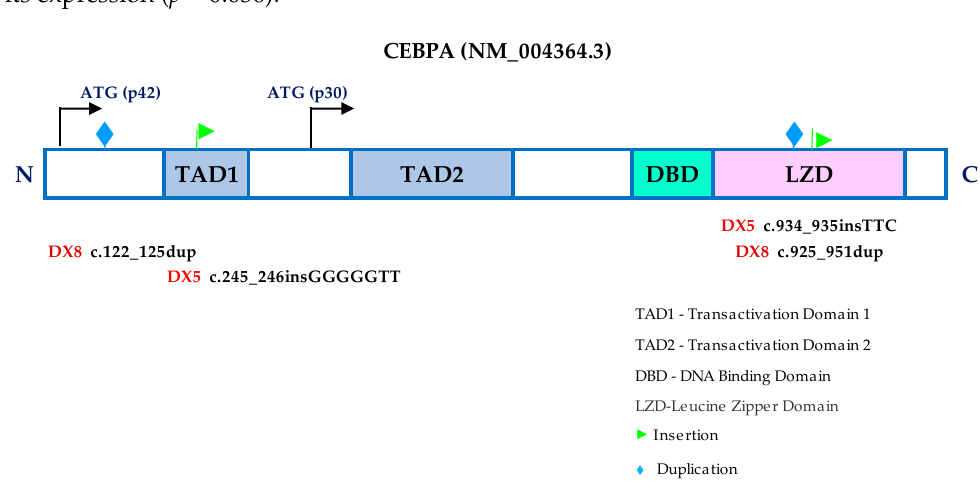
terms in BP, MF and CC are also illustrated using volcano plots in Figures SW6–SW8,